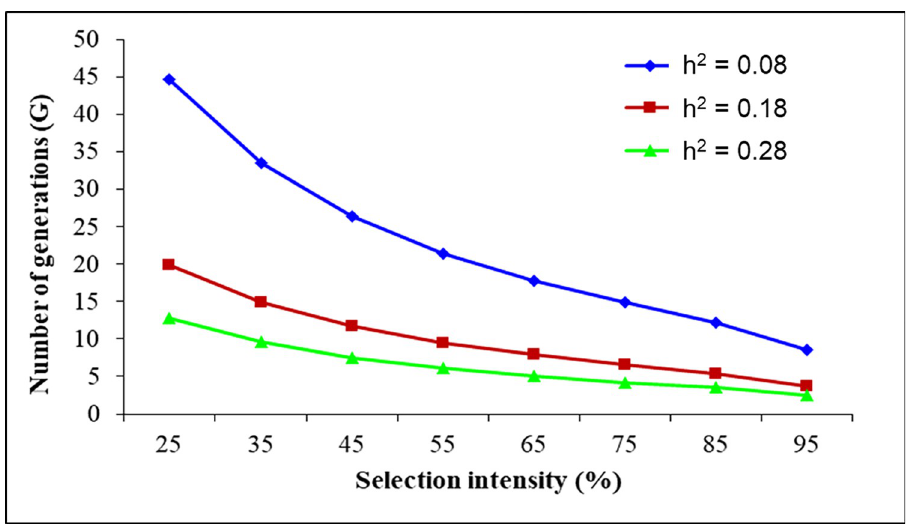
Fig 1. Effect of heritability on the number of generations of M . domestica needed for a 10-fold increase in LC 50 for diflubenzuron at different selection intensities and constant slope (1.51).